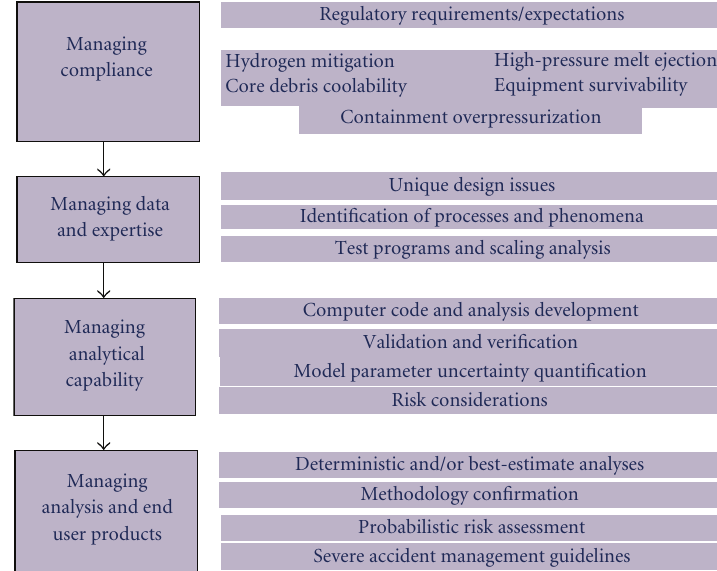
Figure 1: Process for severe accident safety issue